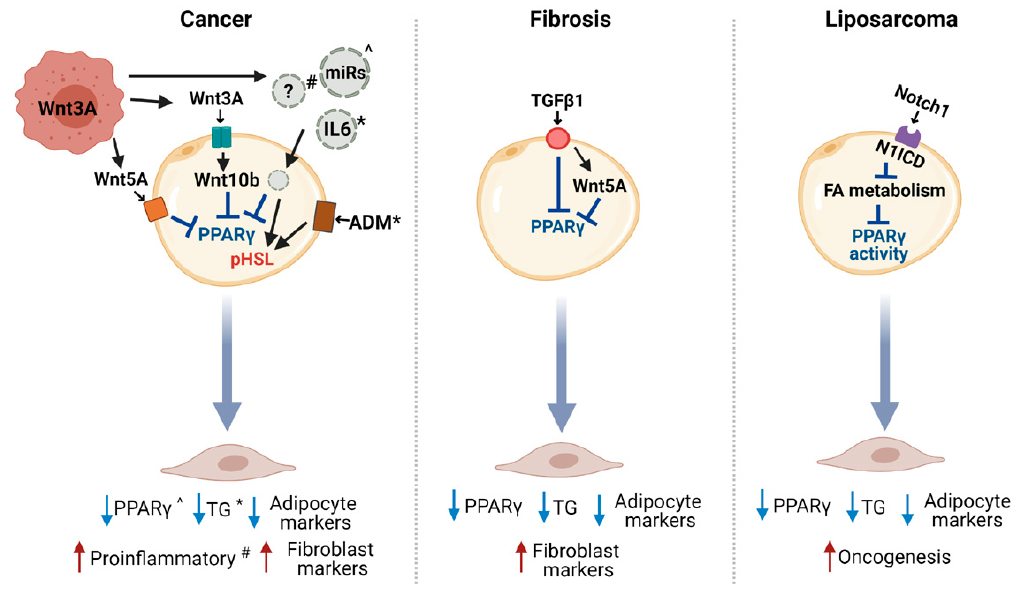
Figure 3. Signaling regulation of adipocyte dedifferentiation. Pathways described to be involved in adipocyte dedifferentia- tion in cancer and in other pathologies like fibrosis and liposarcoma. ?, indicates that the molecule(s) contained in exosomes and involved in inducing the adipocyte pro-inflammatory phenotype are unknown and have only pro-inflammatory effects ( # ); *, IL-6 was described to induce lipolysis and, thus, to reduce triglyceride (TG) content, while adrenomedullin (ADM) was described to induce the phosphorylation of hormone-sensitive lipase (HSL), a step necessary for lipolysis induction that reduces the TG content; ˆ, miRs were demonstrated to induce PPAR γ reduction. Blue and red arrows indicate reduction and increase, respectively. miR, microRNA; FA, fatty acid; pHSL, phosphorylated hormone sensitive lipase; TGF, transforming growth factor; N1ICD, Notch1 intracellular domain; WNT, wingless-related integration